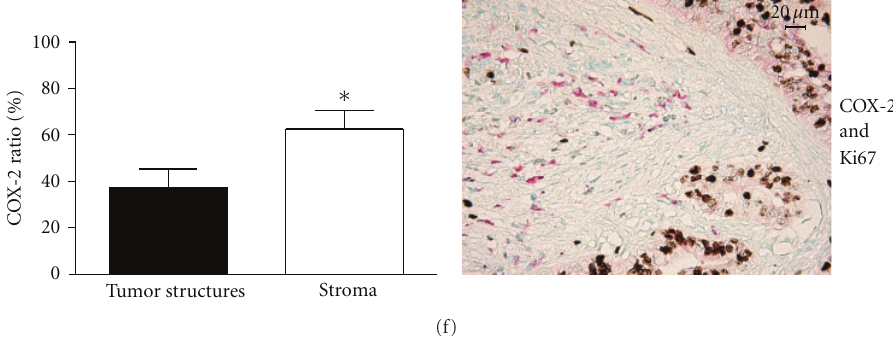
Figure 3: The majority of inflammatory factors in PDAC microenvironment were expressed by the stroma cells. Human PDAC tissue sections were immunostained with anti-COX-2, -CCL20, -CCL2, -CXCL8, and -IL-1 α antibodies (abs) followed by alkaline phosphatase- conjugated secondary abs and visualized with fast red chromogen. Photographs show the staining (red) for (a) IL-1 α positive tumor structures, (b) CXCL8 positive tumor stroma, (c) CCL2 positive fibrotic cells, (d) CCL20 positive tumor and stromal cells, and (e) COX-2 positive tumor cells and stroma. Size bar 20 μ m. (f) To evaluate the ratio between tumor cell and stroma expressed COX-2, PDAC tissue sections were immunohistochemically stained with anti-COX-2 (red) and anti-Ki-67 abs (brown), followed by alkaline phosphatase- and HRP-conjugated secondary abs and detected using fast red chromogen and DAB, respectively. Areas of double positive cells (tumor nests) were compared to nonproliferative COX-2 positive stroma using a computerized image processing analysis system. ∗ P < 0 .